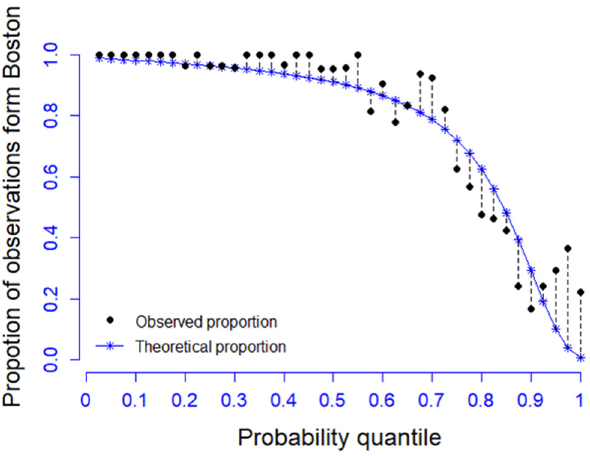
Figure 5. Theoretical and empirical proportions.